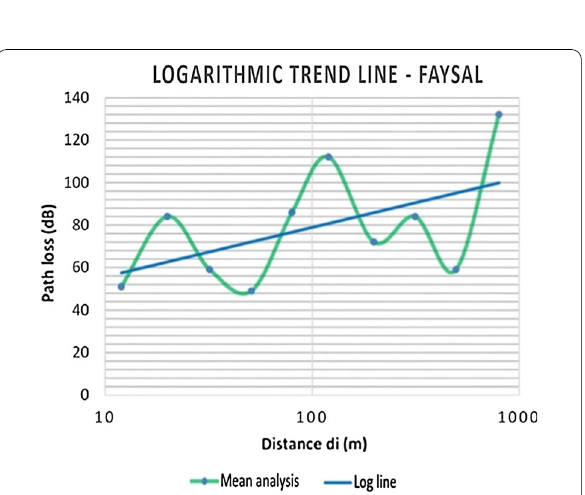
Fig. 9 Regression analysis—logarithmic trend